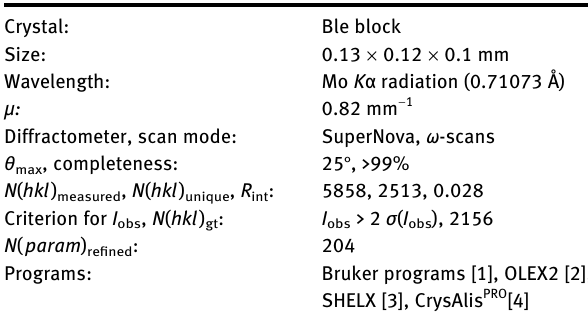
Figure 1: The molecular structure of title compound. Table  : Data collection and